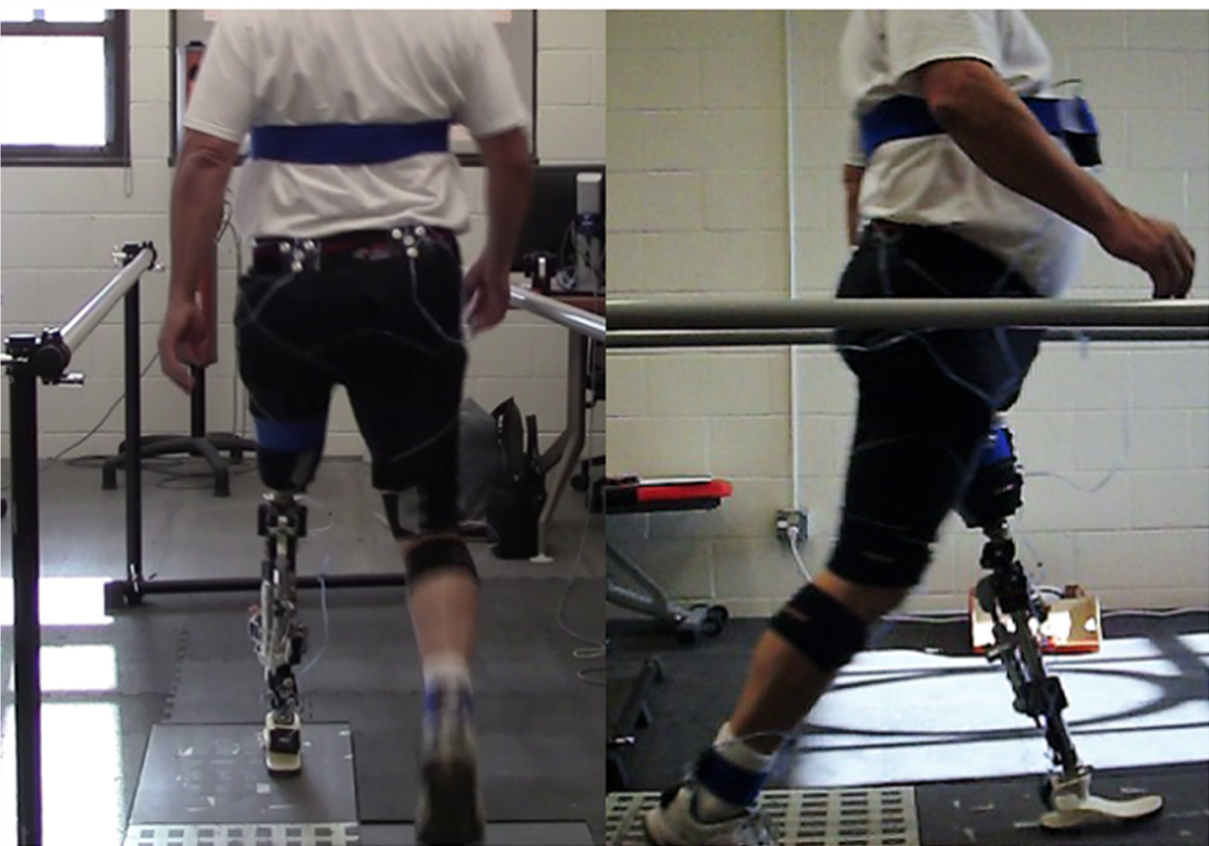
Figure 1. Subject 1 during walking trial on E-Knee. Posterior ( left ) and sagittal ( right ) views.